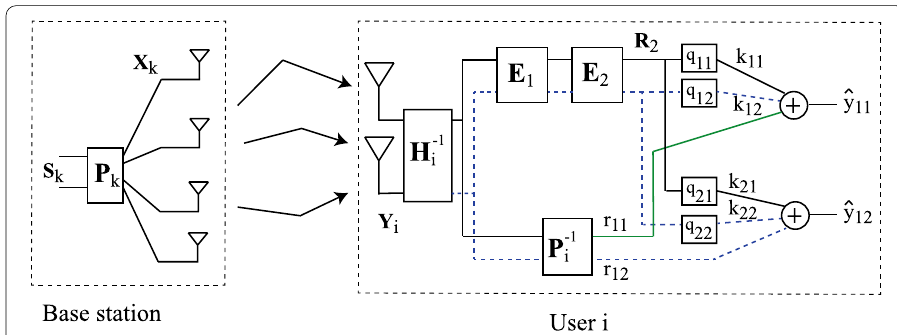
Fig. 2 The structure of proposed method of combined precoding and